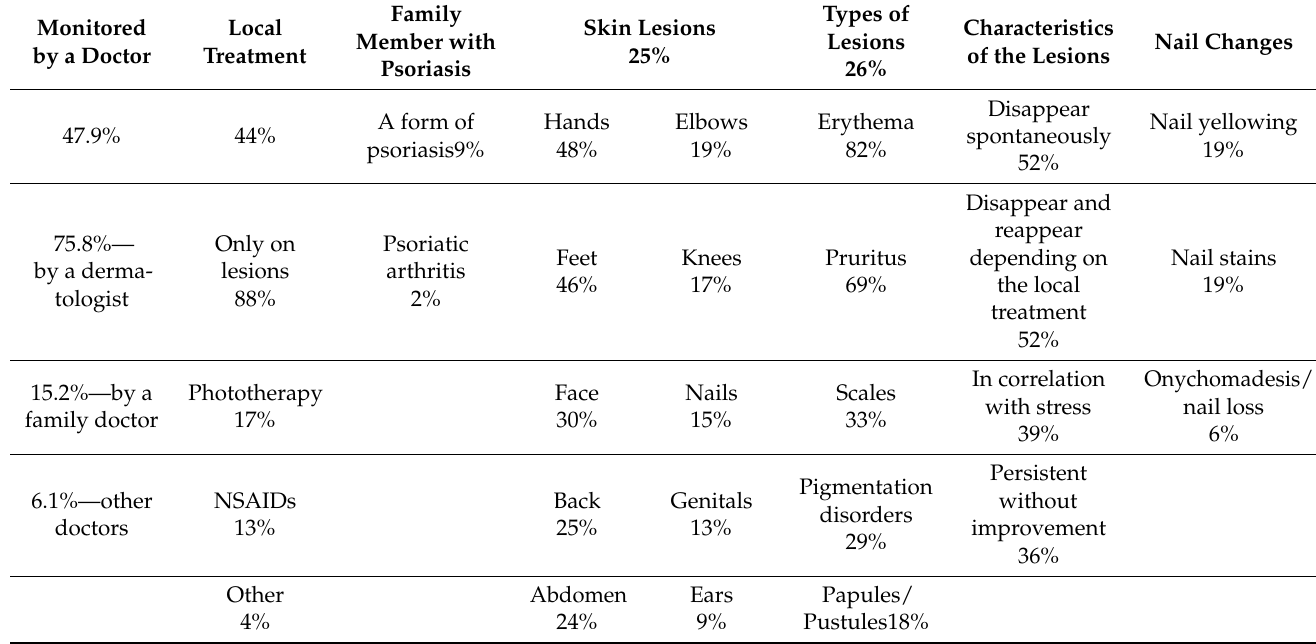
Table 3. Results and data analysis of the national study (N = 1500